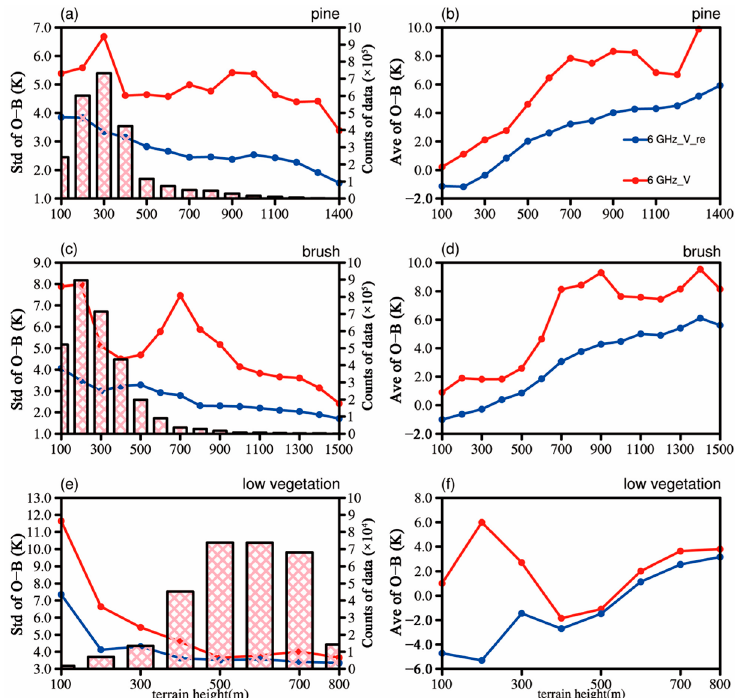
Figure 11. Variation curves of the OMB mean values ( b , d , f ) and standard deviations ( a , c , e ) charac- terizing the 6.9-GHz-V AMSR-2 channel with terrain height in the U.S. in 2016. The red and blue lines represent the pre- and post-repair results, respectively.